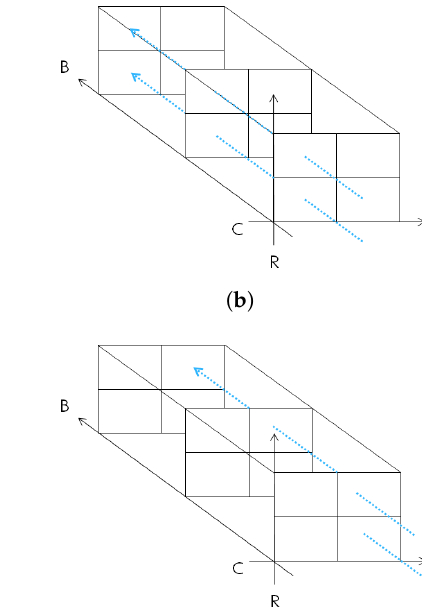
Figure 6. Ship loading rules’ searching flows. ( a ) Rule Lr 1 . ( b ) Rule Lr 2 . ( c ) Rule Lr 3 . ( d ) Rule Lr 4 .